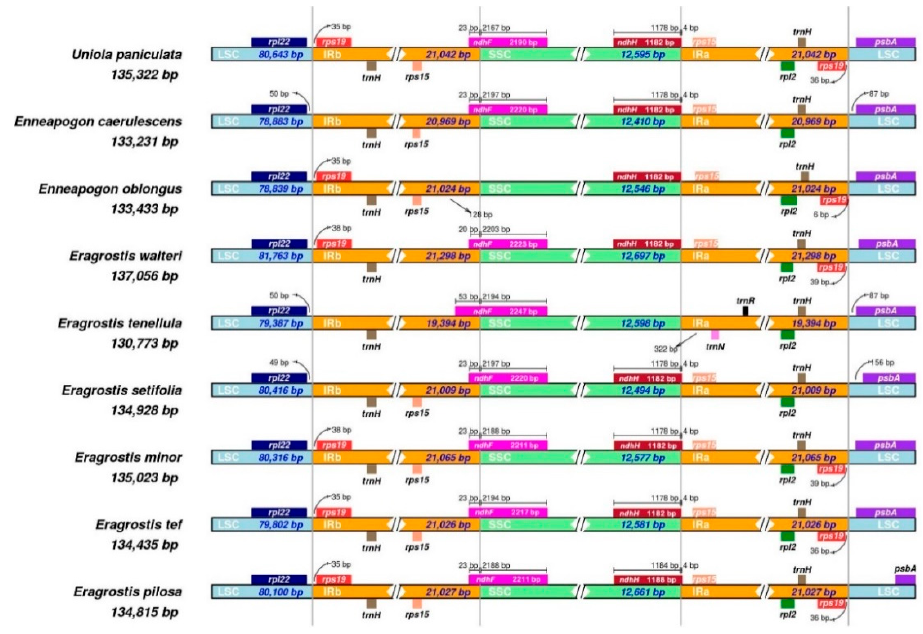
Figure 2. Comparison of LSC, SSC and IR borders among nine chloroplast genome of Eragrostideae.